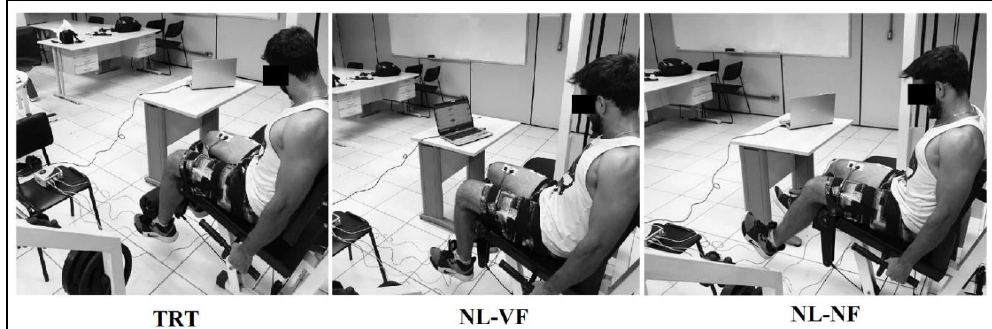
Figure 1. Experimental conditions. TRT, traditional resistance training, NL-VF, no load with visual feedback; NL-NF, no load with no feedback.